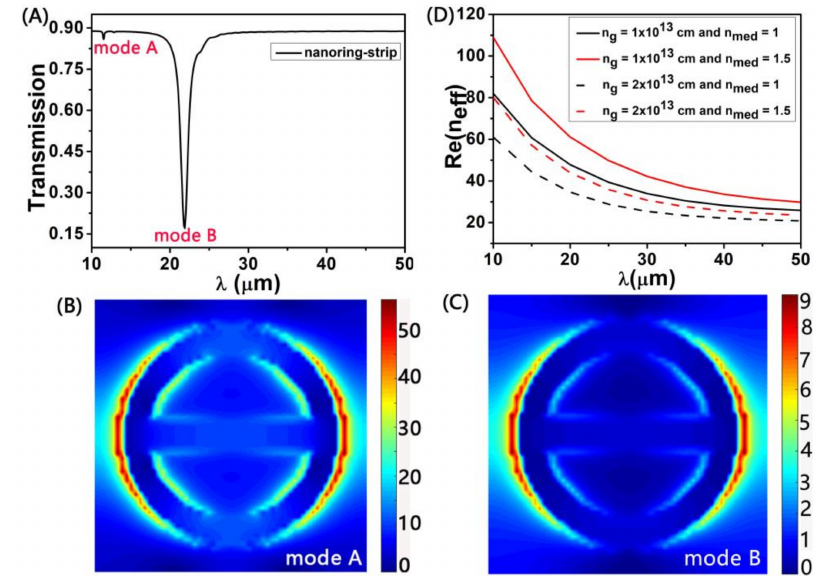
Figure 2. ( A ) The transmission spectra of the nanoring-strip (strip length L = 180 nm, nanoring width W 1 = 30 nm, and strip width W 2 = 30 nm). ( B ) and ( C ) The electric field distribution of nanoring-strip structure in shorter wavelength (mode A) and longer wavelength (mode B), respectively. ( D ) Calculated effective refractive indices of different the n g and the sensing medium refractive index n med